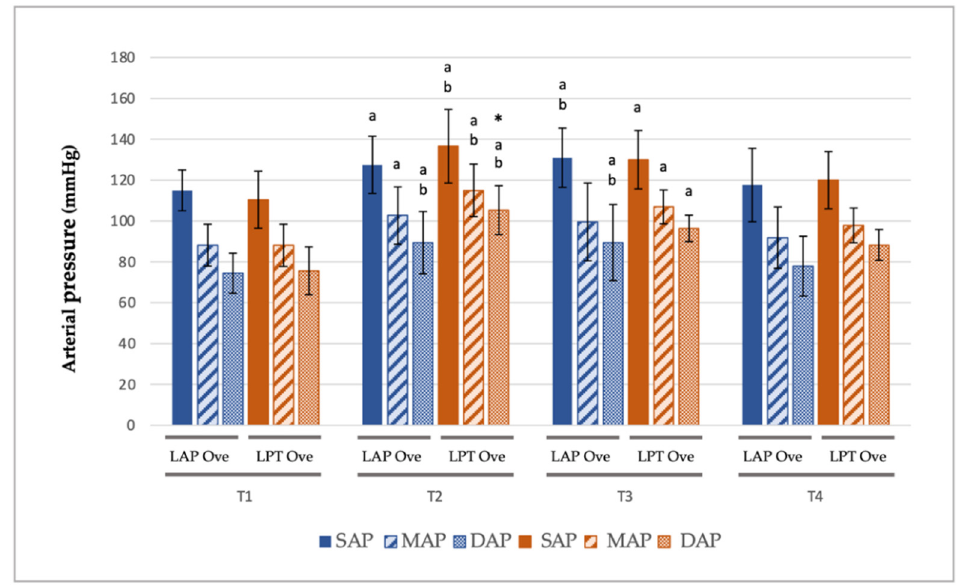
Figure 4. Invasive arterial blood pressure at different points in time along the experimental period. Values given as a mean ± SD. p < 0.05: * vs. the LAP Ove group at the same time; a vs. T1 and b vs. T4, within the same Ove group.